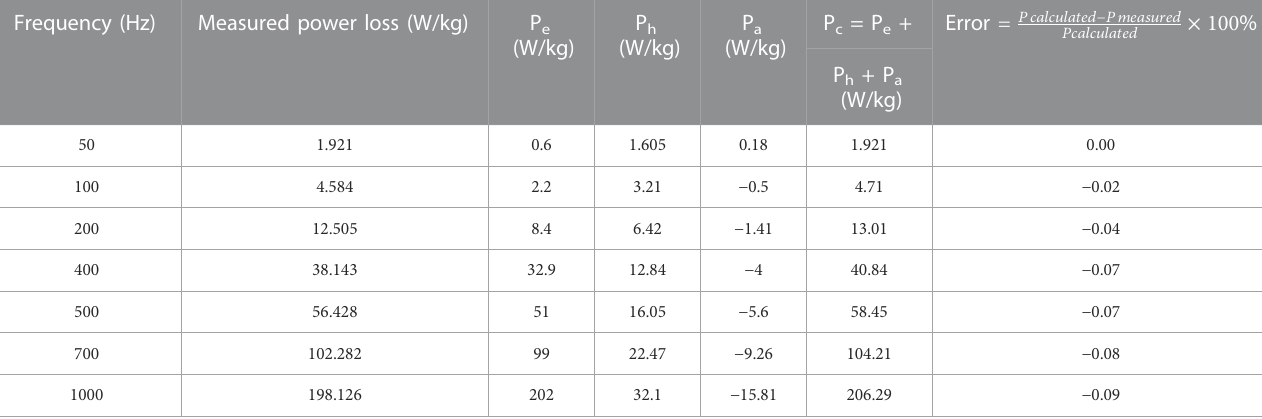
Figure 3 explains the SEM and EDS analysis of typical inclusions in the fi nal annealed samples. The samples were coated and polished using acetone. Scanning electron microscope and EDS was performed